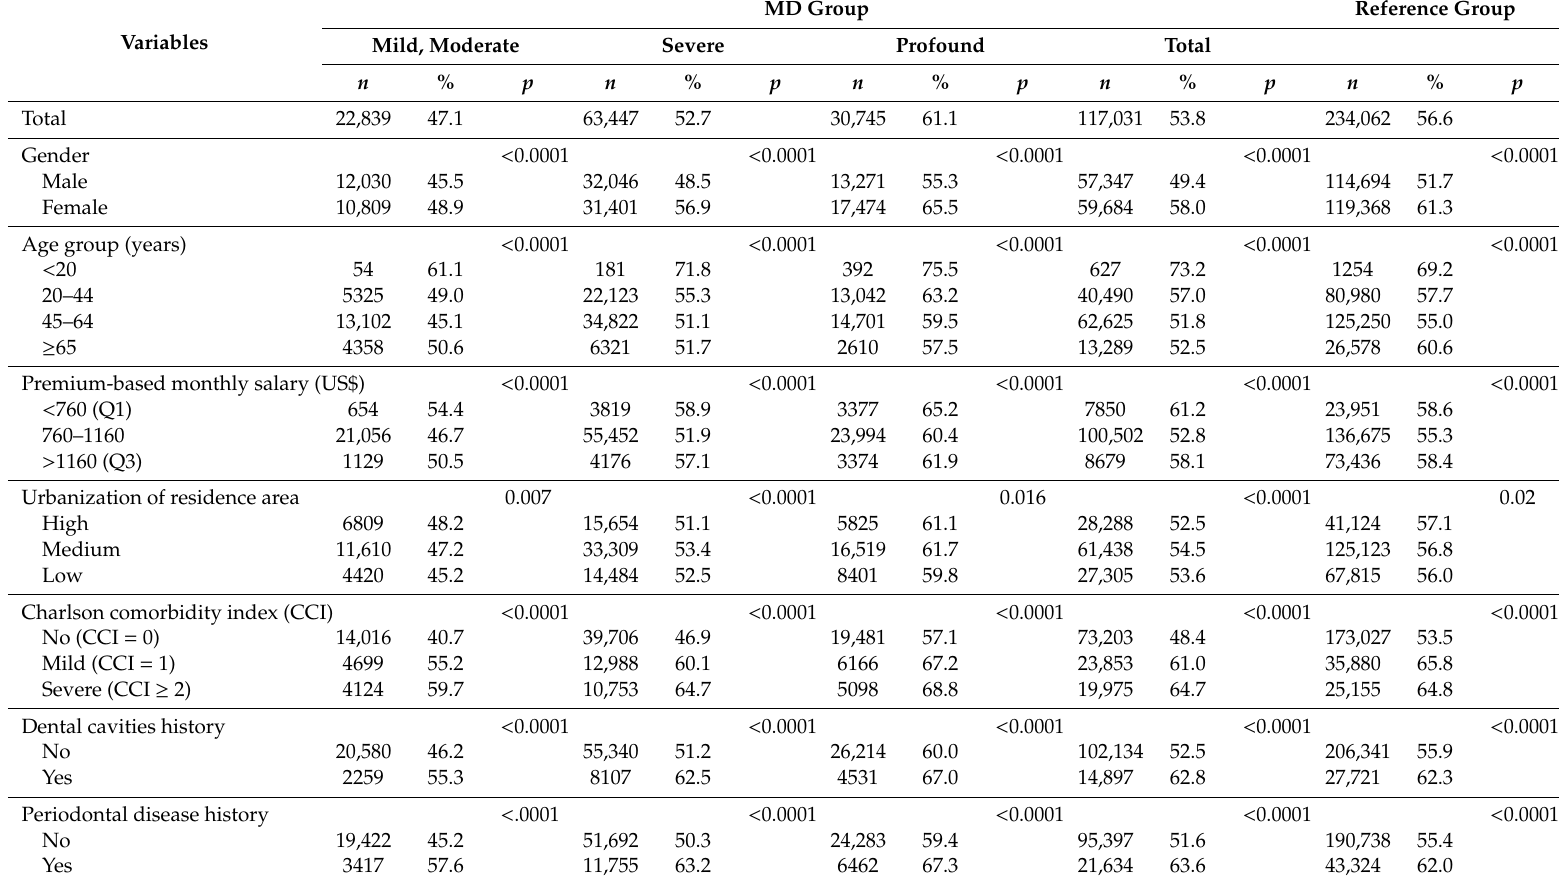
Table 2. Rates of respiratory infection-related healthcare utilization among individuals in the MD and reference